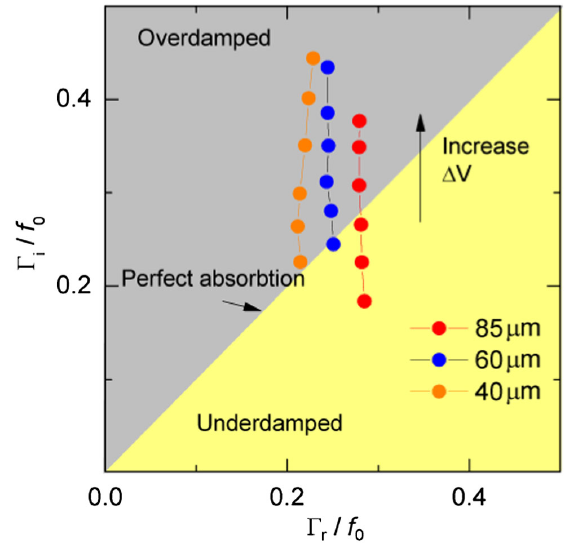
FIG. 10. Critical transition modulated by doping and the spacer layer thickness. We determine Γ simulation results with Eq. (1). Three device structures (with spacer layer thicknesses 40, 60, and 85 μ m) are examined, and the relative gate voltage is varied from 0 to 1.5